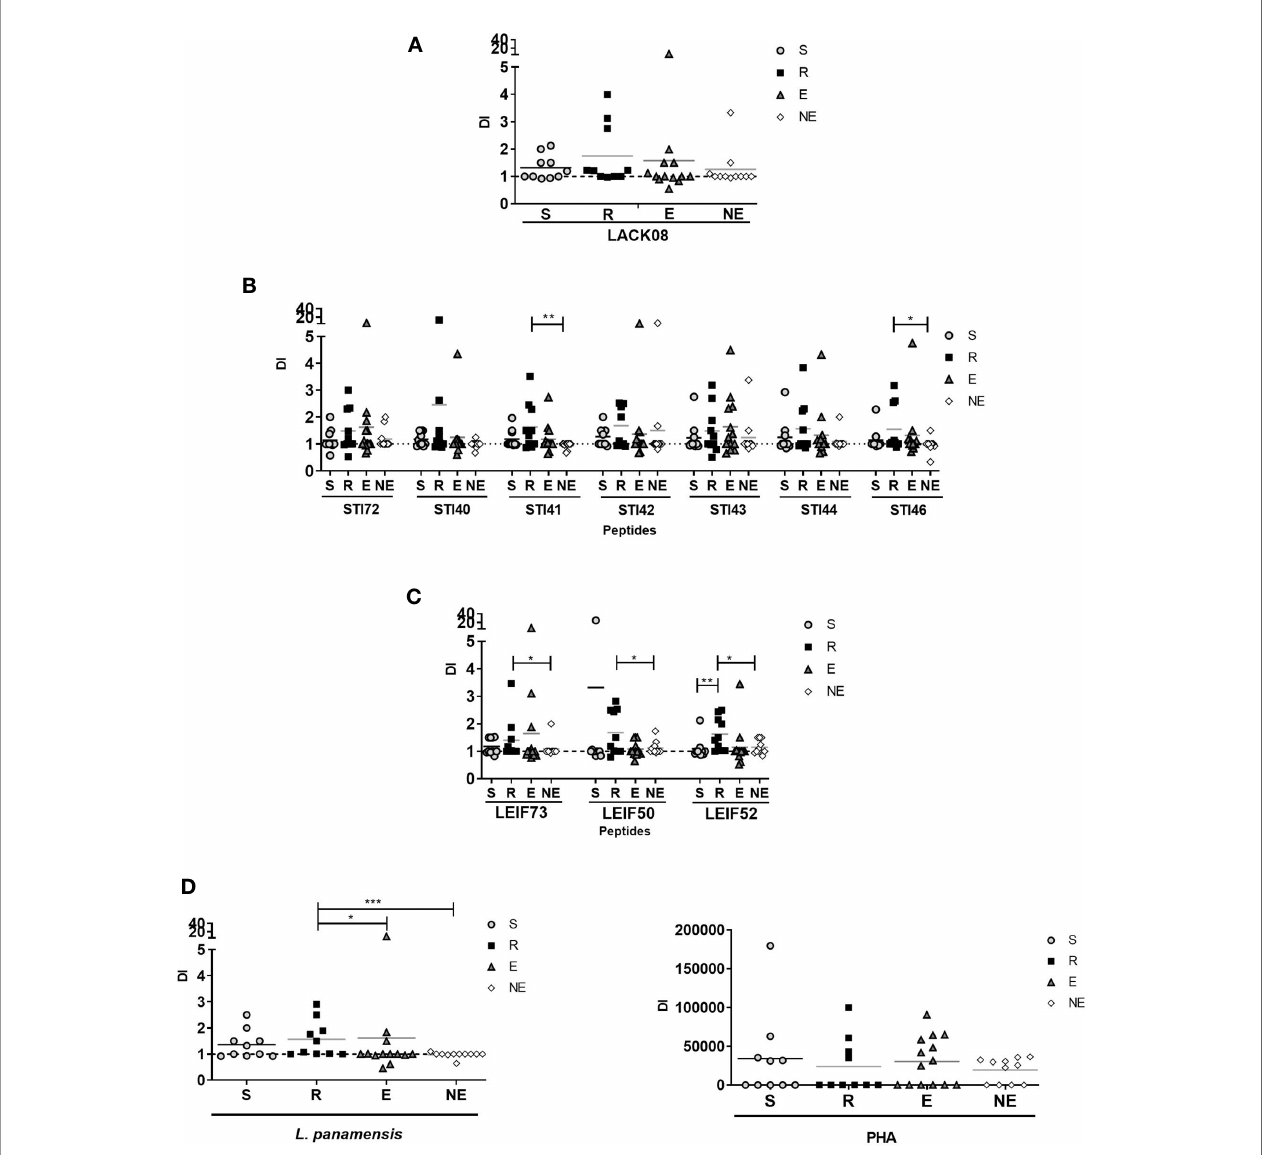
FIGURE 3 | Division Index (DI) evaluated in S (susceptible), R (resistant), E (exposed), and NE (not exposed) groups. Cells response to (A) peptides derived from LACK protein; (B) peptides derived from STI1 protein; (C) peptides derived from LEIF, and (D) L. panamensis or PHA. p<0.05(*), P<0.01(**), P<0.001(***). Dashed line: non-stimulated cell